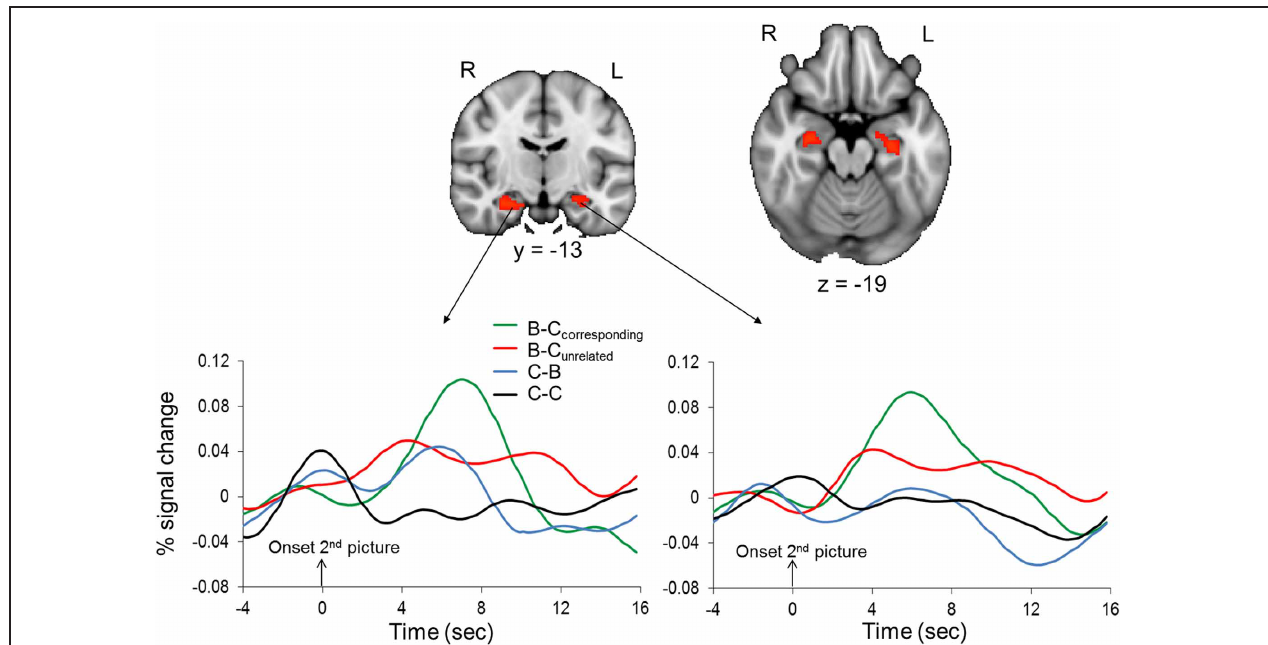
FIGURE 5 | Hippocampal activation associated with the reduction of perceptual uncertainty. Upper panel: the colored regions were more active when the second picture in a trial reduced the perceptual uncertainty induced by the preceding picture (i.e., the second picture in the B–C corresponding condition) than when the second picture did not reduce the perceptual uncertainty induced by the preceding picture (i.e., the second picture in the